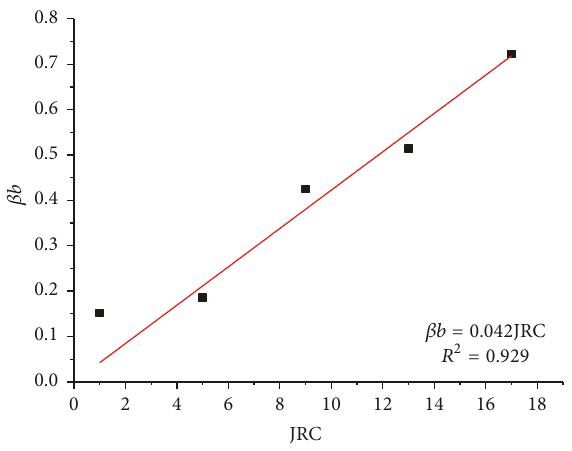
Figure 13: Fitting curves between 𝛽𝑏 and JRC.